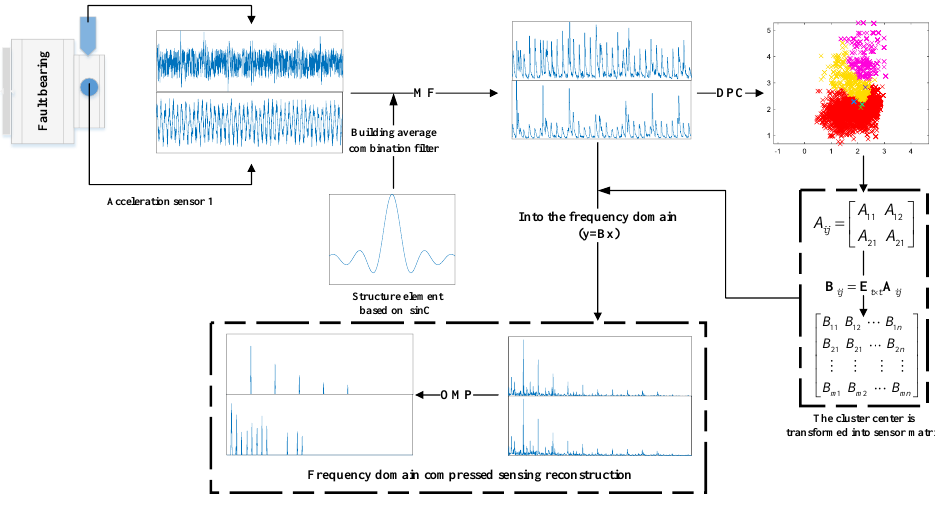
Figure 1. Flow chart based on SMF − DPC − OMP.